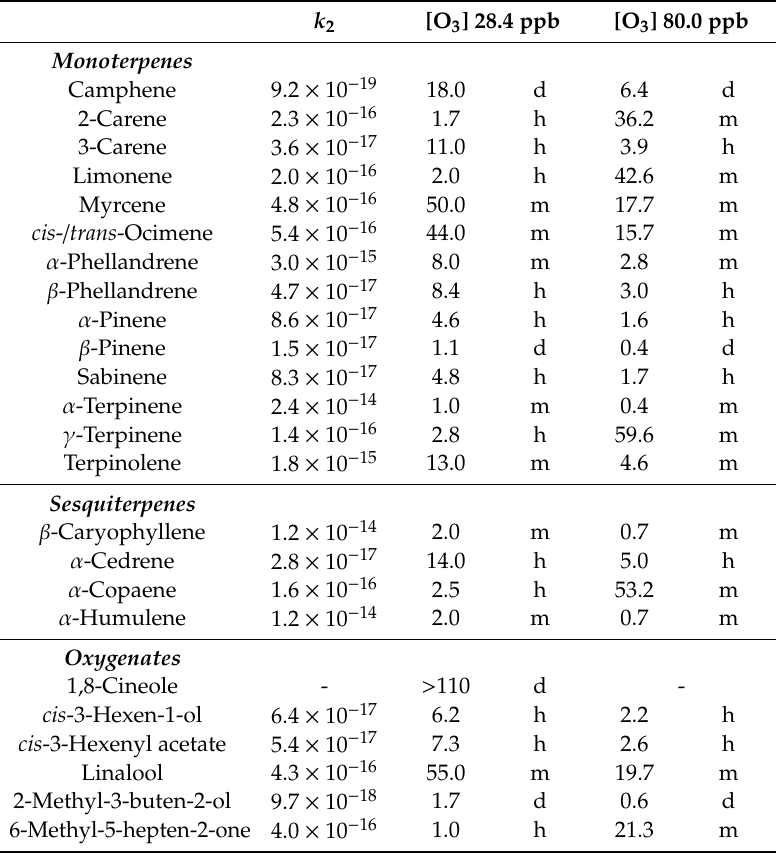
Table 1. Biogenic volatile organic compounds’ (BVOCs) atmospheric